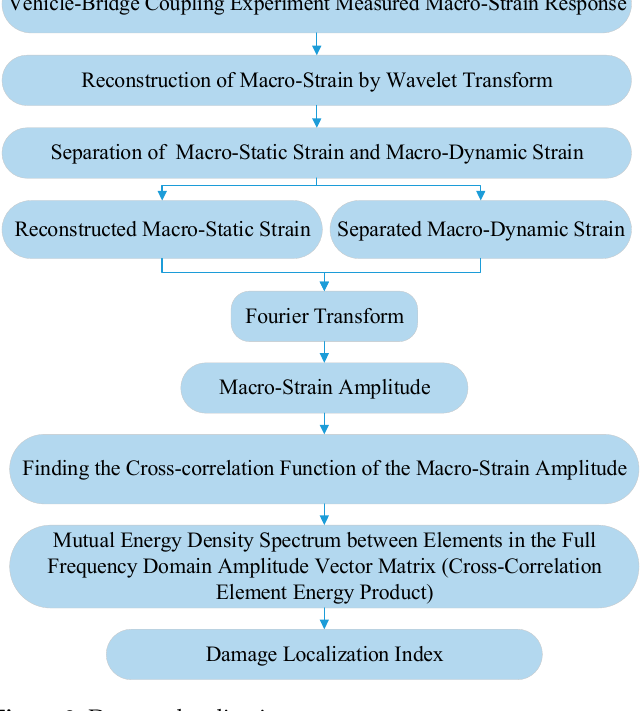
Figure 3. Damage